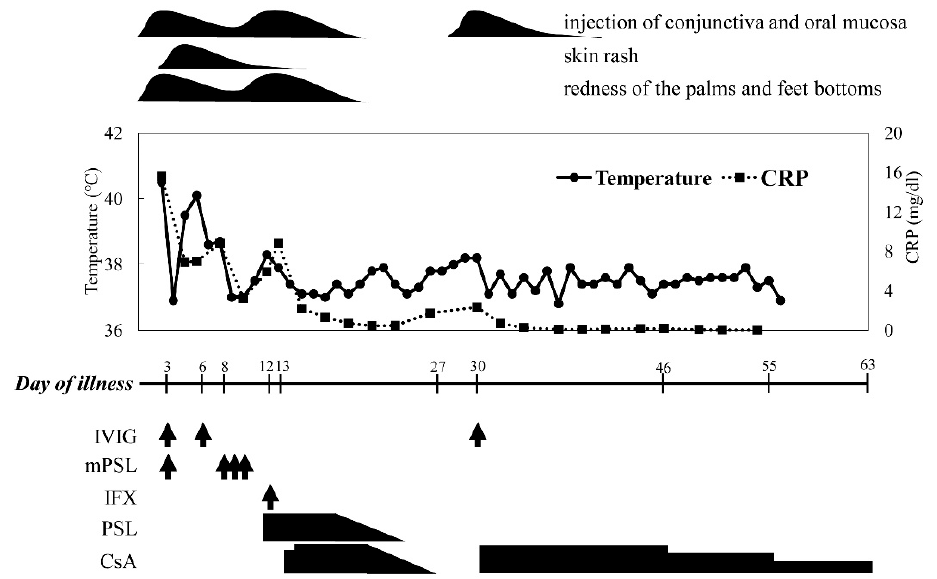
Figure 1. The clinical course of the present case. Abbreviations and administered dose of the therapeutic agents: CRP, C-reactive protein; IVIG, intravenous immunoglobulin (2 g/kg/day); m-PSL, methylprednisolone (30 mg/kg/day); IFX, infliximab (5 mg/kg/day); PSL, prednisolone (1 mg/kg/day per os); CsA, cyclosporine A (6 mg/kg/day per os with a target trough level between 100–150 ng/mL); arrows indicate the intravenous administrations of therapeutic agents. Table 1. Laboratory and Echocardiogram Data in the Clinical Course.